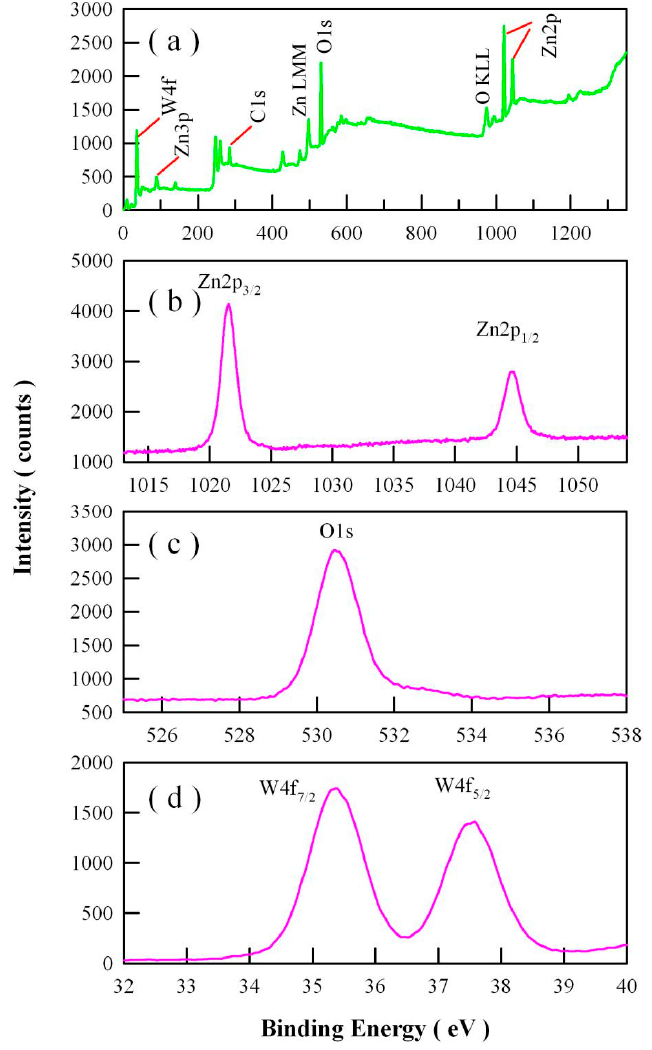
Figure 12. XPS survey scan ( a ), and XPS spectra of Zn 2p ( b ), O 1s ( c ), and W 4f ( d ) in ZnWO 4 nanoparticles.